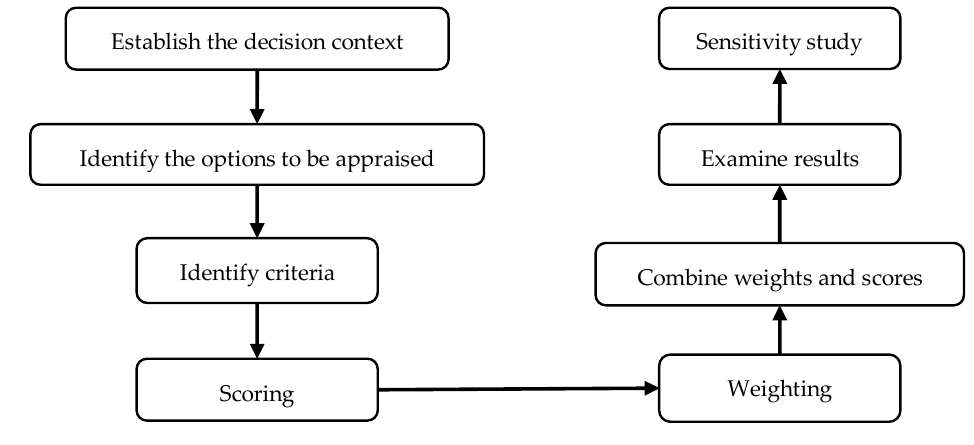
Figure 4. Process of an MCDA.